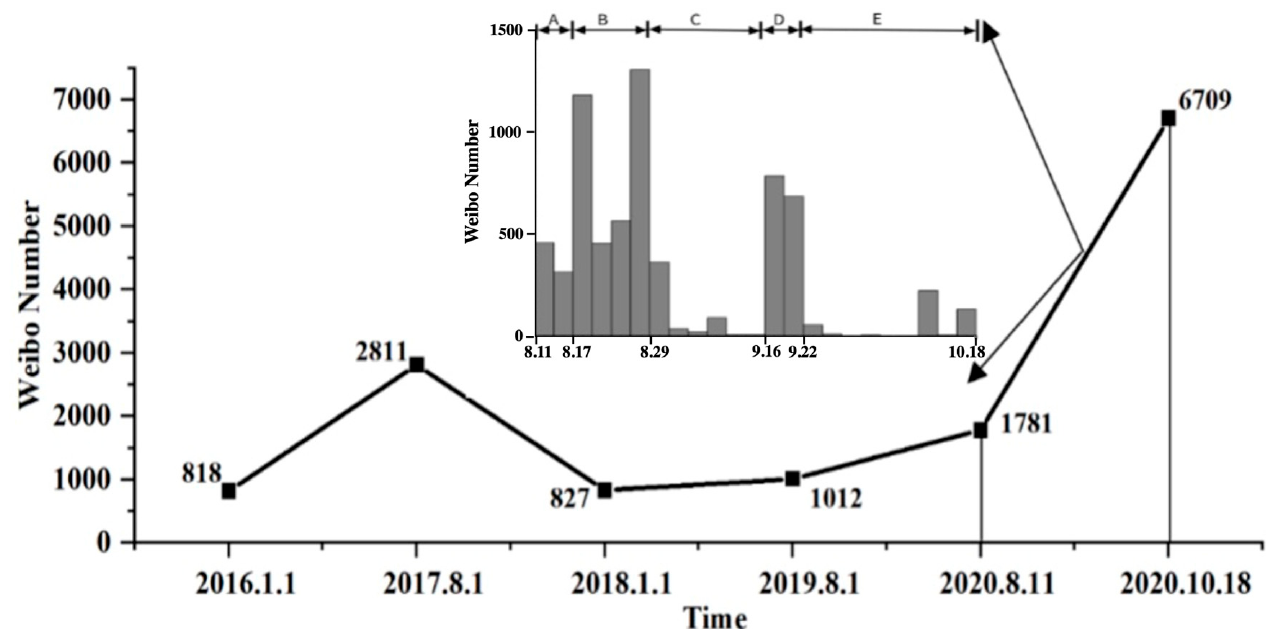
Figure 1. Trends in public concern about food waste. A–E represent five stages. A: incubation pe-